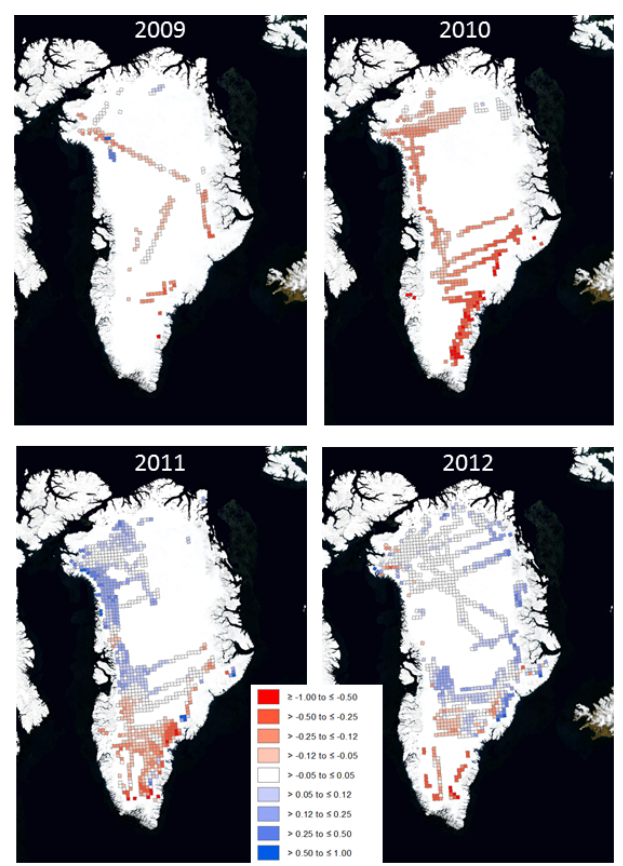
Figure 10. Difference between annual radar-derived and MAR- estimated accumulation rate (mw.e.a − 1 ) showing higher MAR val- ues in red and lower in blue.